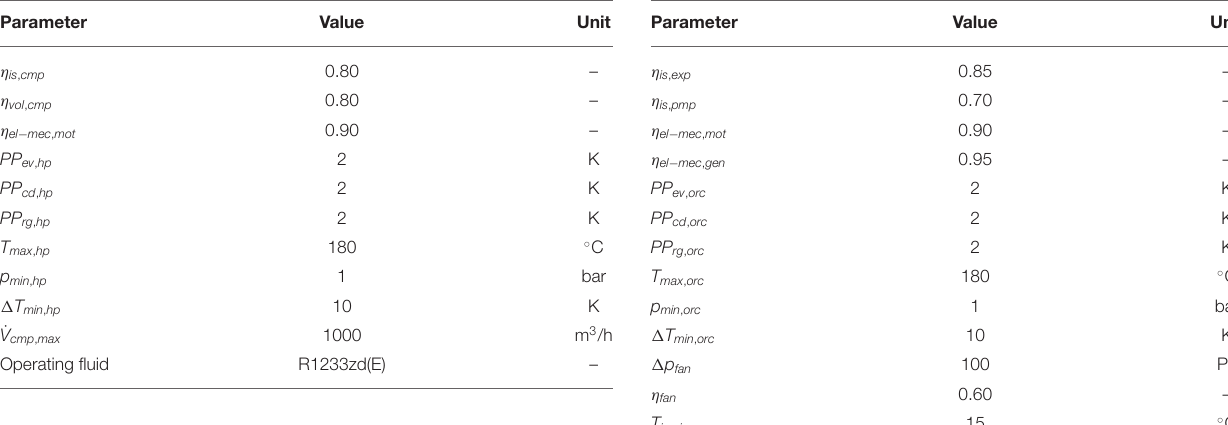
TABLE 1 | HT-VCHP technical and operational parameters. TABLE 2 | ORC technical and operational